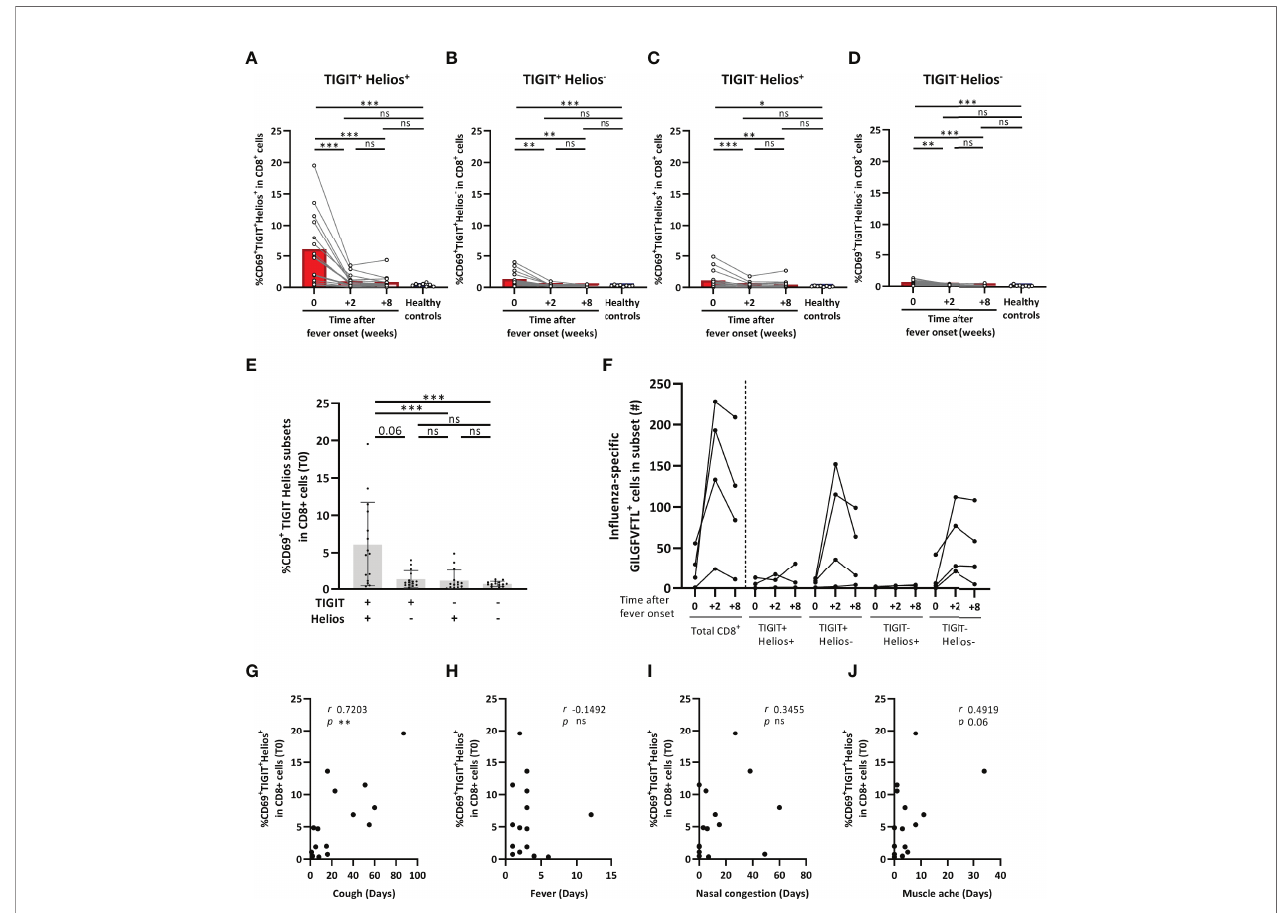
FIGURE 3 | TIGIT + Helios + CD8 + T cells are highly activated during in fl uenza-A infection and correlate with prolonged coughing. (A – D) Bar graphs show the frequency of CD69 + TIGIT/Helios cell subsets within the total CD8 + T-cell population as detected in blood of older adults at the acute phase of in fl uenza with con fi rmed in fl uenza-A infection (0), and two (+2) and eight (+8) weeks after onset of fever (63-83 years of age, n = 15; H3N2 n = 12, H1N1 n = 3), as well as in older adult asymptomatic controls (61-82 years of age, n=8). (E) Bar graph shows the frequency of CD69 + TIGIT/Helios cell subsets within the total CD8 + T-cell population in in fl uenza-A infected individuals at the acute phase of in fl uenza. (F) Graph shows the number of cells speci fi c for the GILGFVFTL in fl uenza A matrix protein epitope at the indicated time after onset of fever within the total CD8 + T-cell population and the TIGIT/Helios cell subsets (n = 4). Relationship between the frequency of CD69 + TIGIT + Helios + cells within the total CD8 + T-cell population and duration of (G) cough, (H) fever, (I) nasal congestion, and (J) muscle ache. Correlations ( r and p values) were assessed by Spearman test. Statistical signi fi cance of data presented in the bar graphs (means ± s.d.) was determined using row-matched one-way ANOVA (with Geisser-Greenhouse correction and Dunnett ’ s post-test) for the difference between the time points and Mann-Whitney U test was used to determine the difference between infected and asymptomatic individuals. (* p < 0.05, ** p < 0.01, *** p < 0.001, ns, not signi fi